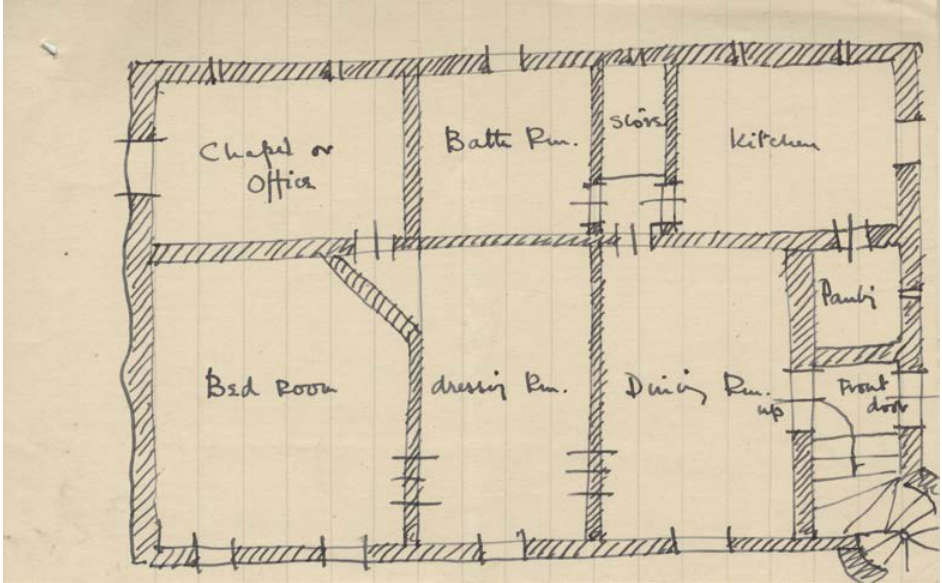
Fig. 6: Plan of the ground floor of ‘Antiquity House’, the Horsfields’ residence in Jerash, show- ing Horsfield’s proposed adjustments to the layout in late 1931. (Copyright UCL Institute of